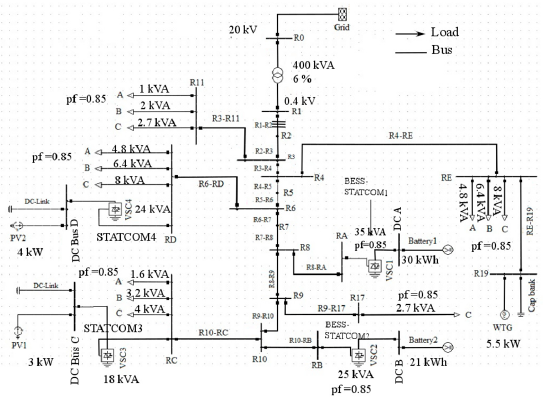
Figure 1. The International Council on Large Electric Systems (CIGRE) low voltage (LV) distribution system [8].